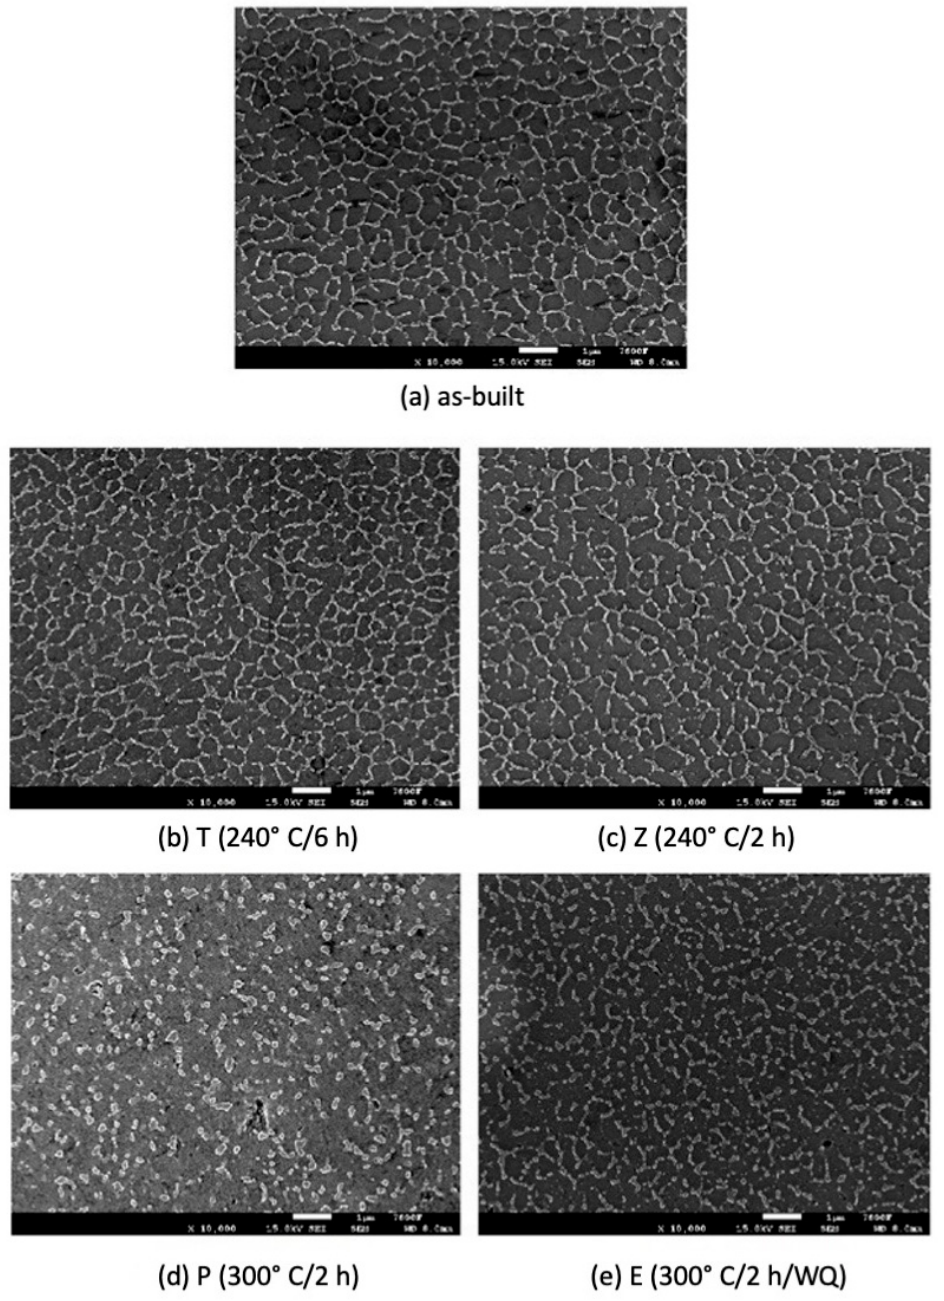
Figure 7. SEM analysis of the microstructure of ( a ) as-built and ( b – e ) stress relief annealed L-PBF AlSi10Mg samples in the transverse cross-sections.